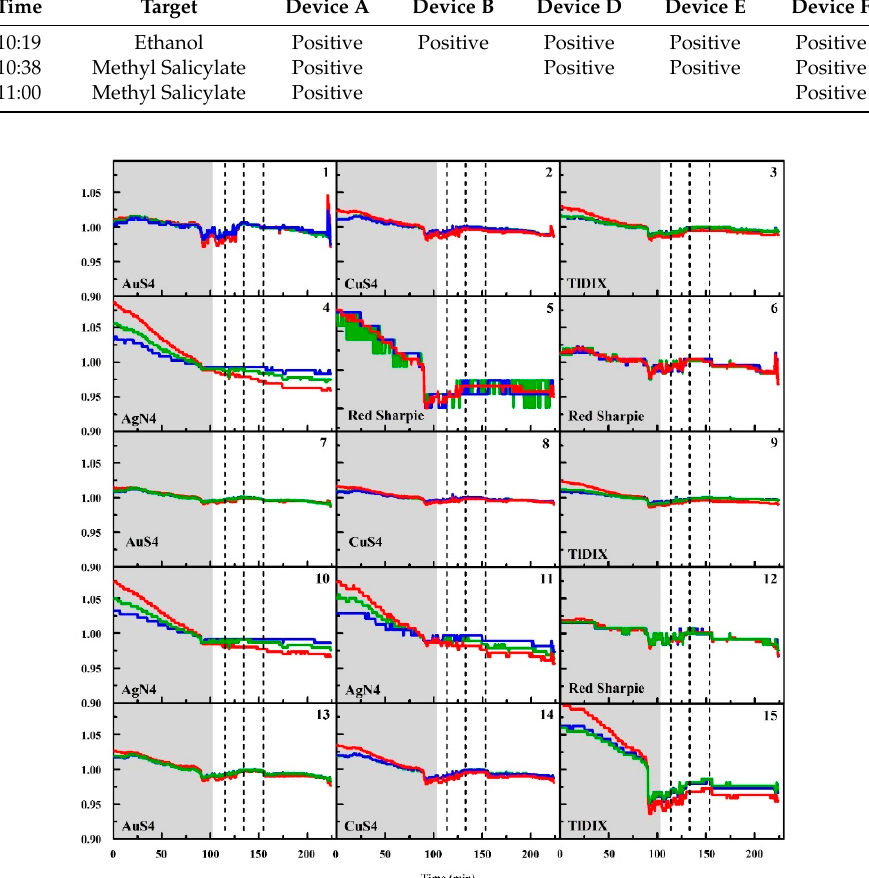
Figure 6. Normalized RGB data from the sensor located at position F (Figure 4). Dashed lines indicate exposure events; the gray shaded region is prior to installation of the sunshade. All three exposures resulted in positive responses from the device. Data are normalized to the average value of the color intensity over the duration of the experiment. Here, the color of the curve (red, blue, green) corresponds to the color value measured.